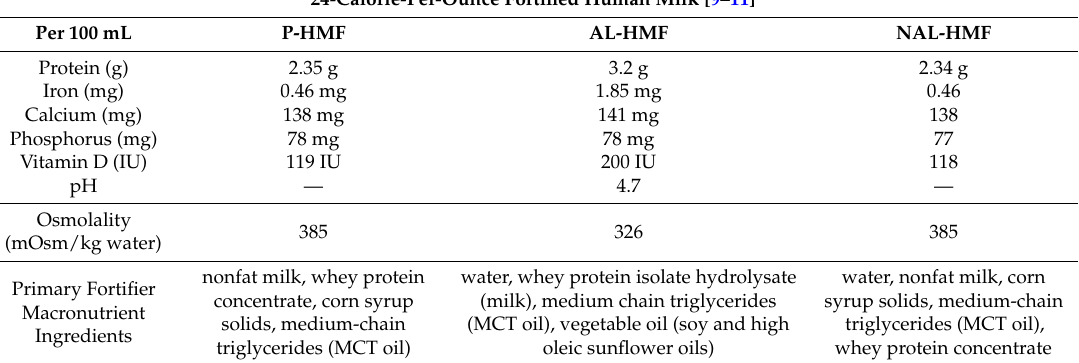
Table 1. Comparison of primary nutrients and ingredients of the powdered, acidified liquid, and non-acidified liquid